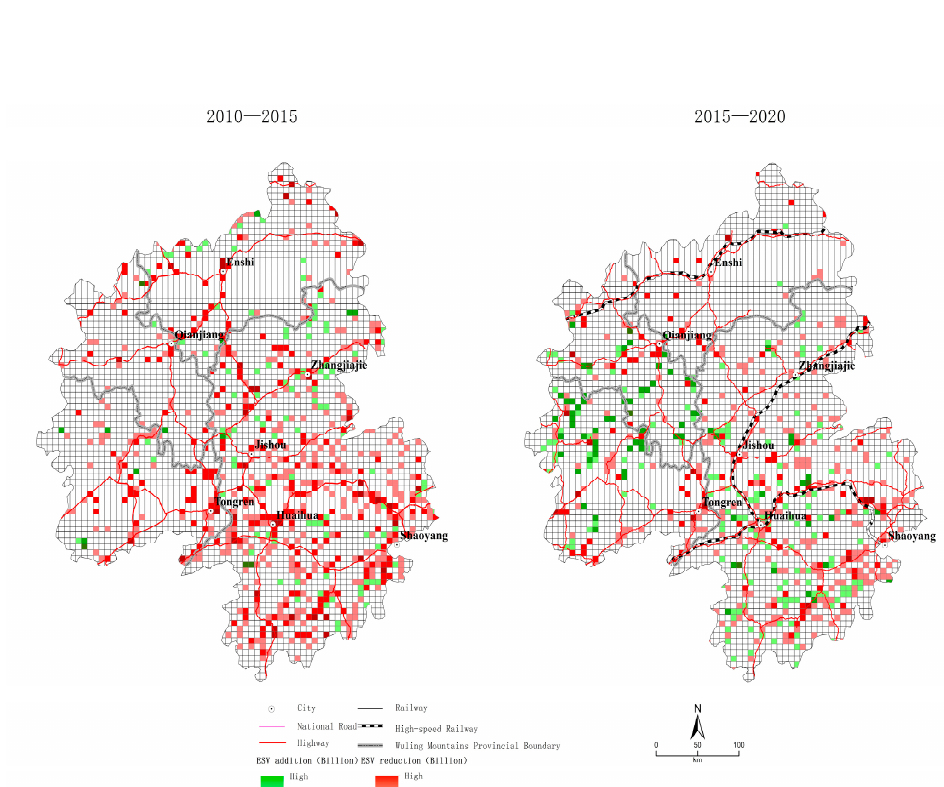
Figure 7. Spatial differentiation of the ecosystem service values in the Wuling Mountains.